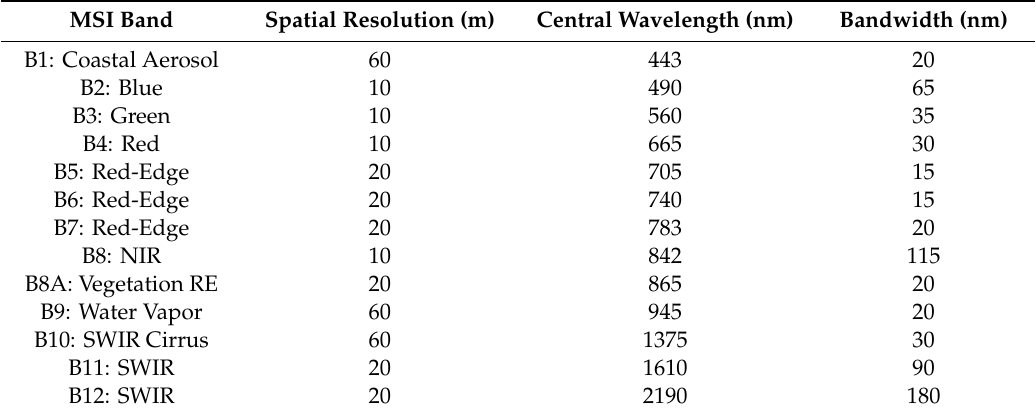
Table 1. Bands and resolutions of Sentinel-2 MultiSpectral Instrument (MSI)